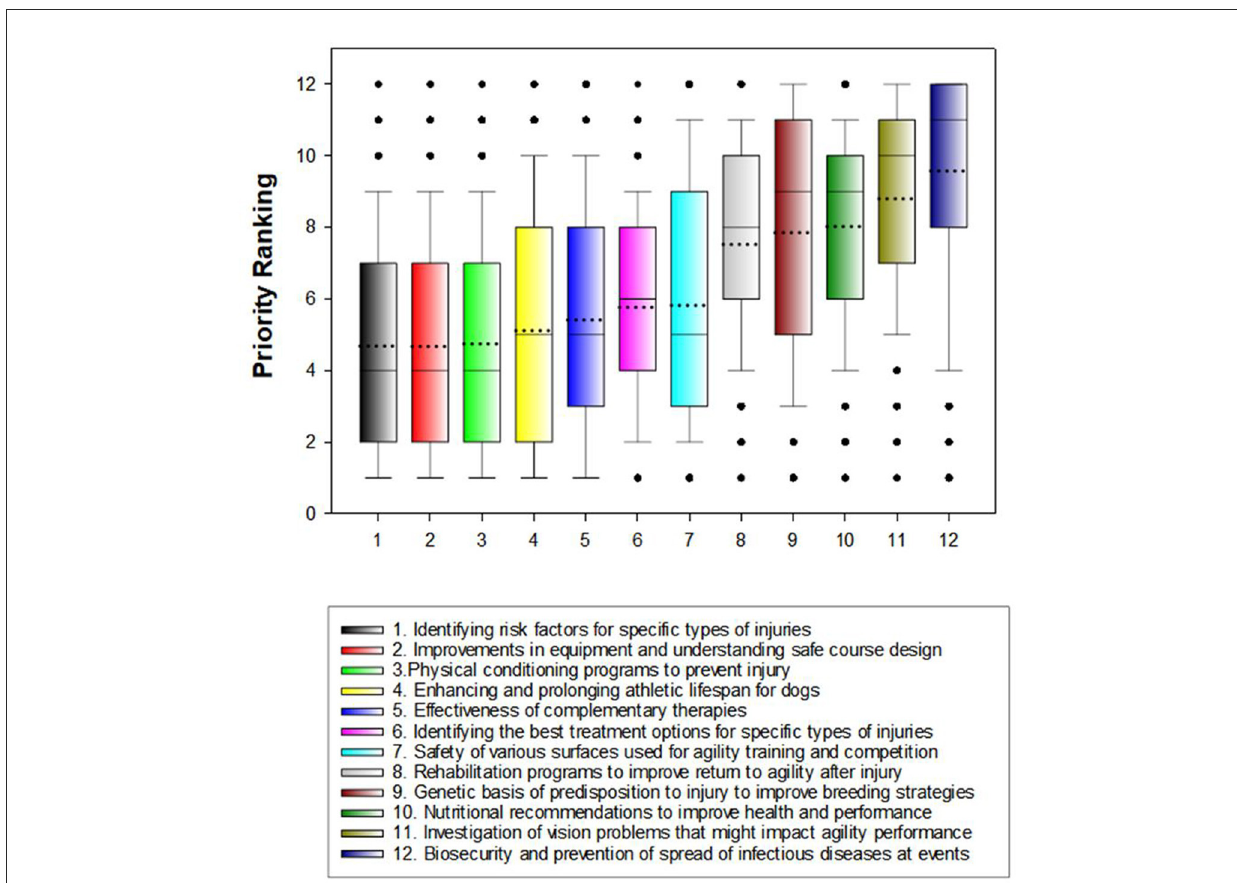
FIGURE2 Box and whiskers plots showing priority rankings of agility dog health research areas. Boxes represent 25th and 75th percentiles and whiskers represent 10th and 90th percentiles. The black line inside each box represents the median ranking value for that research area and the dotted black line represents the mean value. Boxes are ordered from highest priority to lowest priority based on mean ranking score. A lower mean ranking indicates a higher priority research